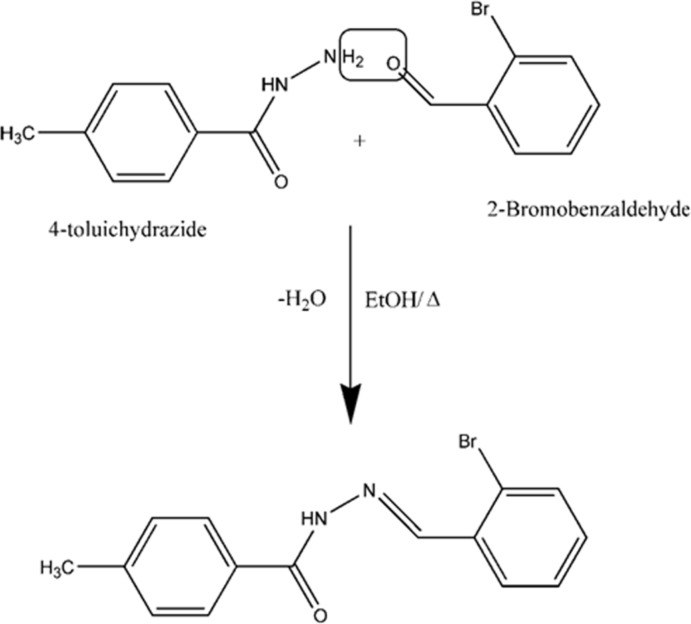
Reaction scheme.